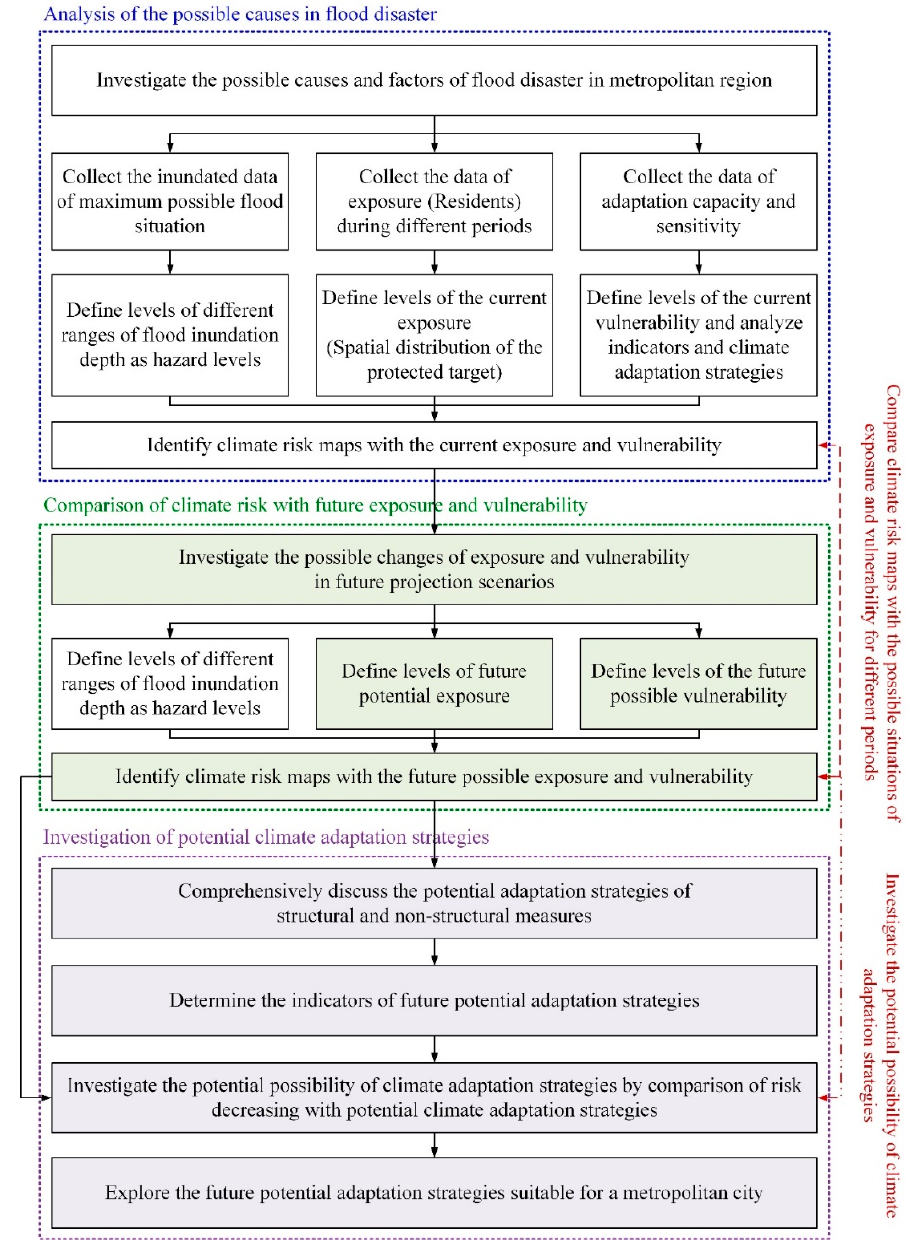
Figure 5. Flowchart of the proposed approach for assessing climate risk and potential climate adaptation strategies.